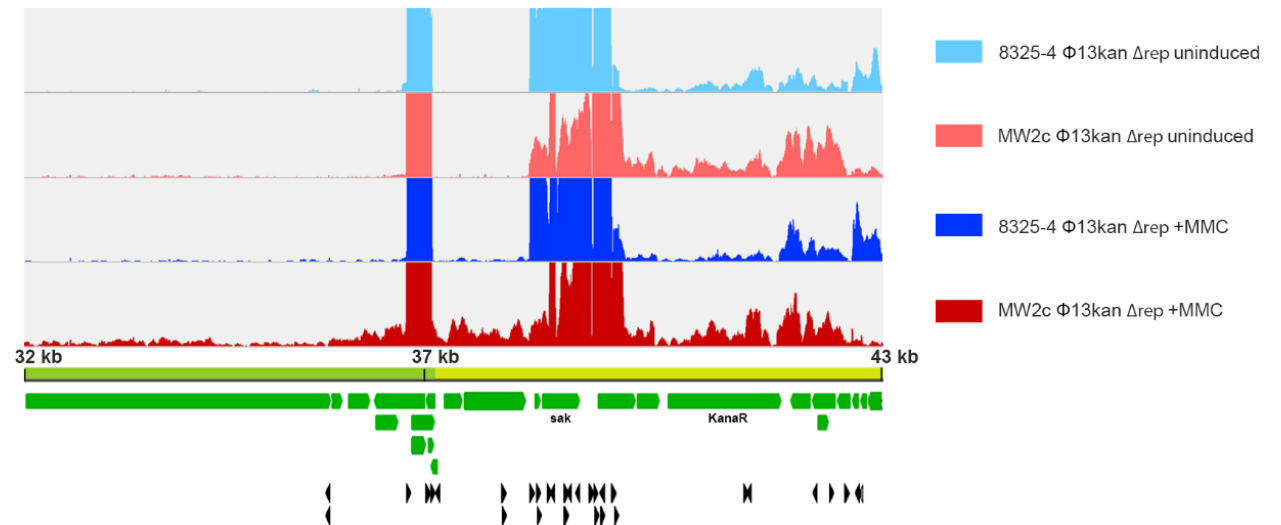
Figure 4. Visualization of predicted and enriched TSS and transcriptional profile of extracted Φ 13 prophage region. Reads mapping to the phage genome are visualized for MW2c- and 8325-4 Φ 13kan- ∆ rep strains under uninduced (light red and light blue, respectively) and induced (1 h mitomycin C treatment; dark red and dark blue) conditions from a representative sample out of 3 replicates. The maximum for the Y-axis in each panel is 200 counts. Protein coding genes are depicted in green and predicted TSS (Table S3) by black arrowheads.